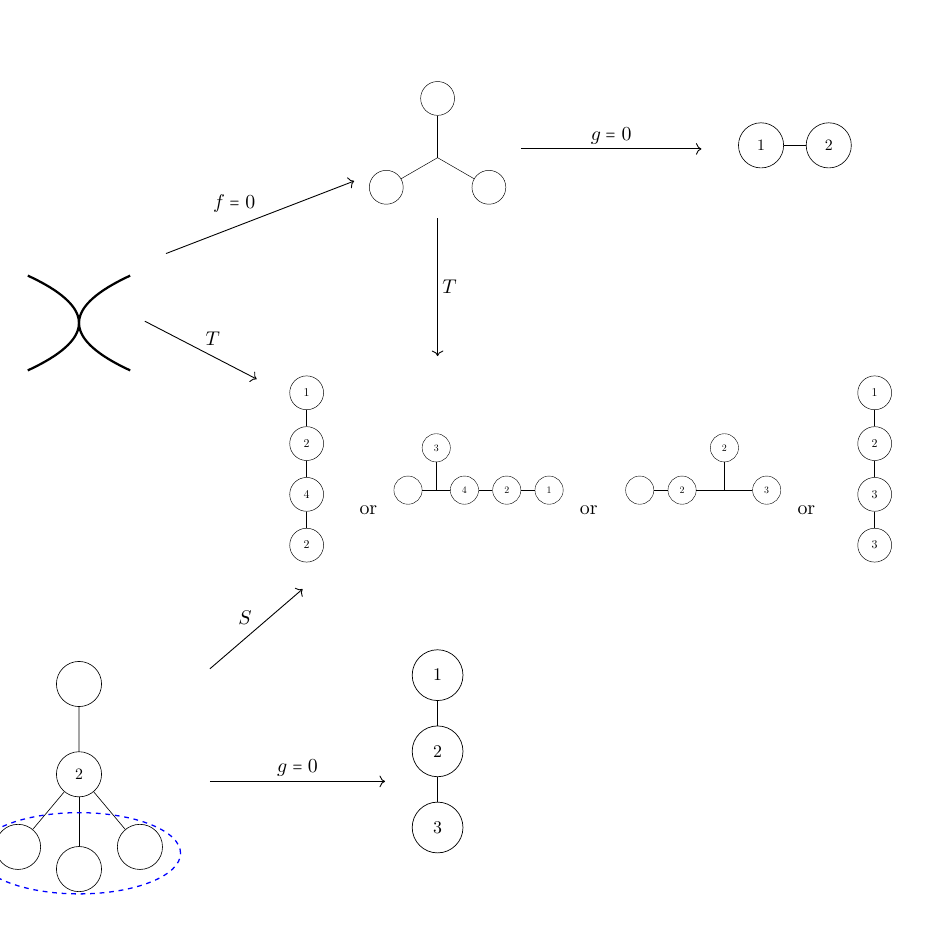
Figure 16 . III + I (cid:3) Z 3 , y 2 = x 3 + fst 3+ (cid:11) x + gs 2 t 3 . Resolution I, II, III, and IV. The (cid:12)bers in 0 codimension-two are arranged in the order of the resolution. There are no more enhancements in higher